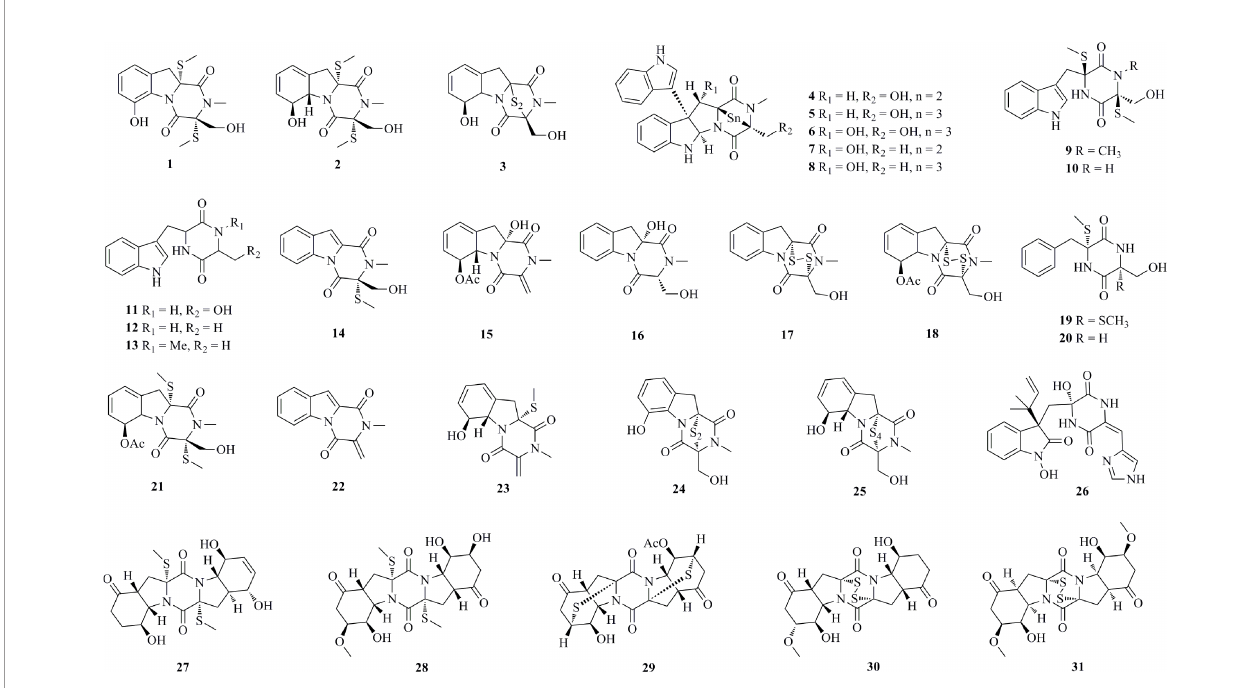
FIGURE 2 | Diketopiperazines isolated from deep-sea fungi ( 1 − 31